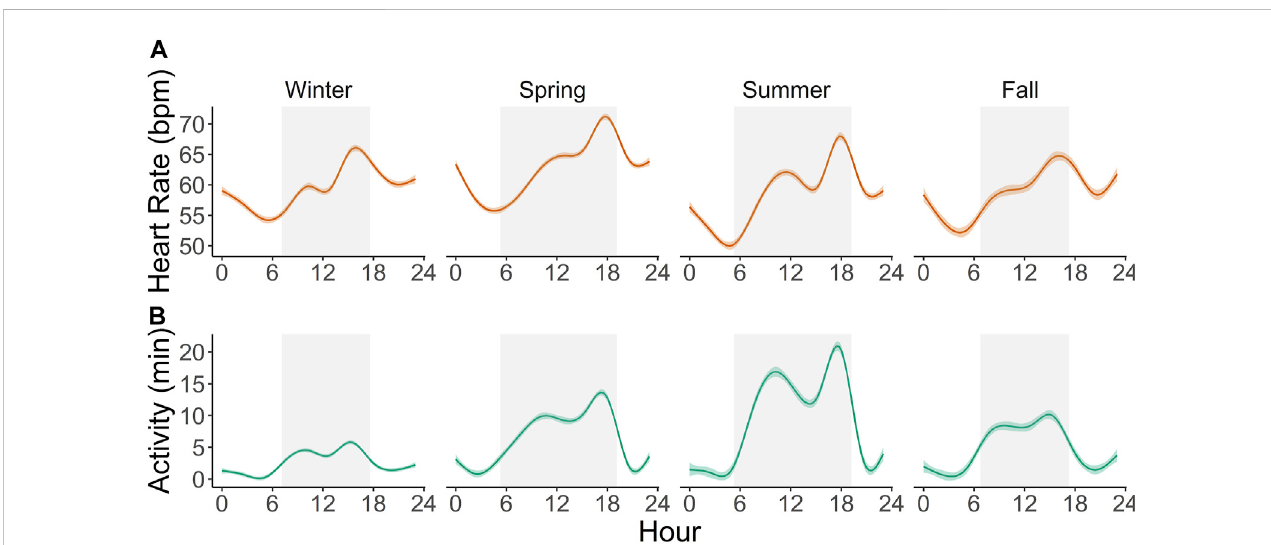
FIGURE 4 Circadian pro fi le of hourly heart rate averages (A) and active minutes per hour (B) in six captive scimitar-horned oryx continuously monitored with an implantable biologger for an average of 592 days. Solid colored lines represent smoothing curves fi tted with the function stat_smooth (method = “ gam ” ) in R and color shaded areas represent 95% con fi dence intervals. Gray rectangles represent the average duration of the day (from dawn to dusk) for each astronomical season. Similar patterns are observed throughout each season, with noticeable biphasic increases in activity and heart rate and maximum peaks occurring before dusk.